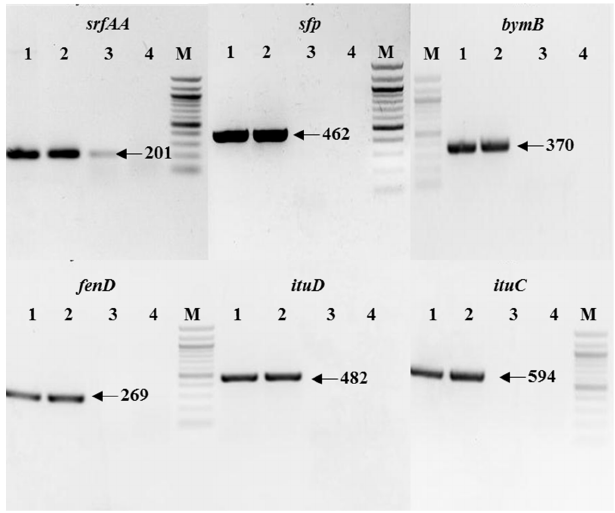
Figure 1. Agarose gel electrophoresis of PCR products for surfactin ( srfAA ), fengycin ( fenD ), bacillomycin ( bymB ), iturin ( ituC and ituD ), and sfp (essential for various LPs synthesis). Lanes 1–4: The biosynthesis genes from B. amyloliquefaciens NCPSJ7, Bacillus sp. 222 (The whole genome was analyzed and acted as positive control. Data were not shown here.), B. subtilis 168, and Clostridium sp. (Negative control). M: 100 bp DNA ladder (Biolabs ® ). The product size as designed was indicated with arrow.